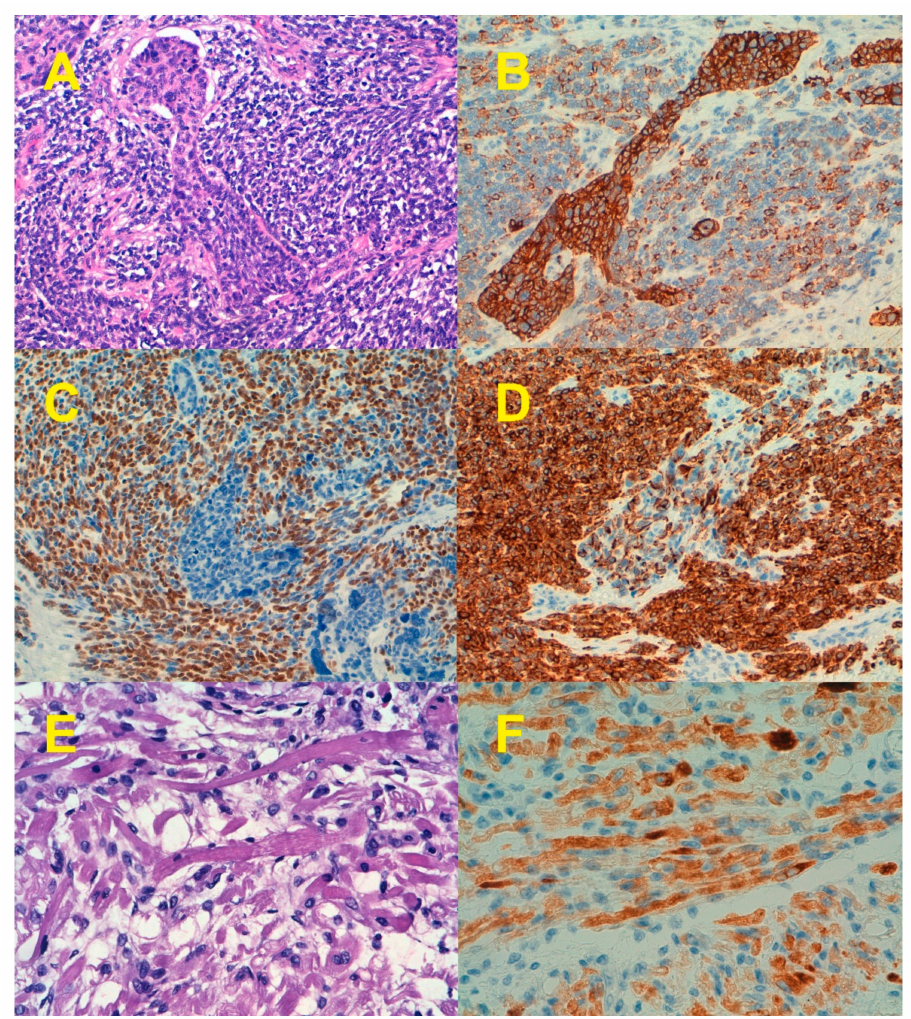
Figure 2. Endometrial carcinosarcoma with rhabdomyoblastic di ff erentiation. Some cells showed an intermediate epithelial / mesenchymal di ff erentiation as suggested by the expression pattern of cytokeratins, myogenin, and desmin. ( A ) Hematoxylin-eosin staining. ( B ) Cytokeratin (CK AE1 / AE3) expression. ( C ) Myoblast determination protein 1 (MyoD1) expression. ( D ) Desmin expression. ( E ) Striated rhadbomyoblasts (H&E). ( F ) Desmin expression by striated rhadbomyoblasts. Original magnification 20 × for A-D, and 40 × for E and